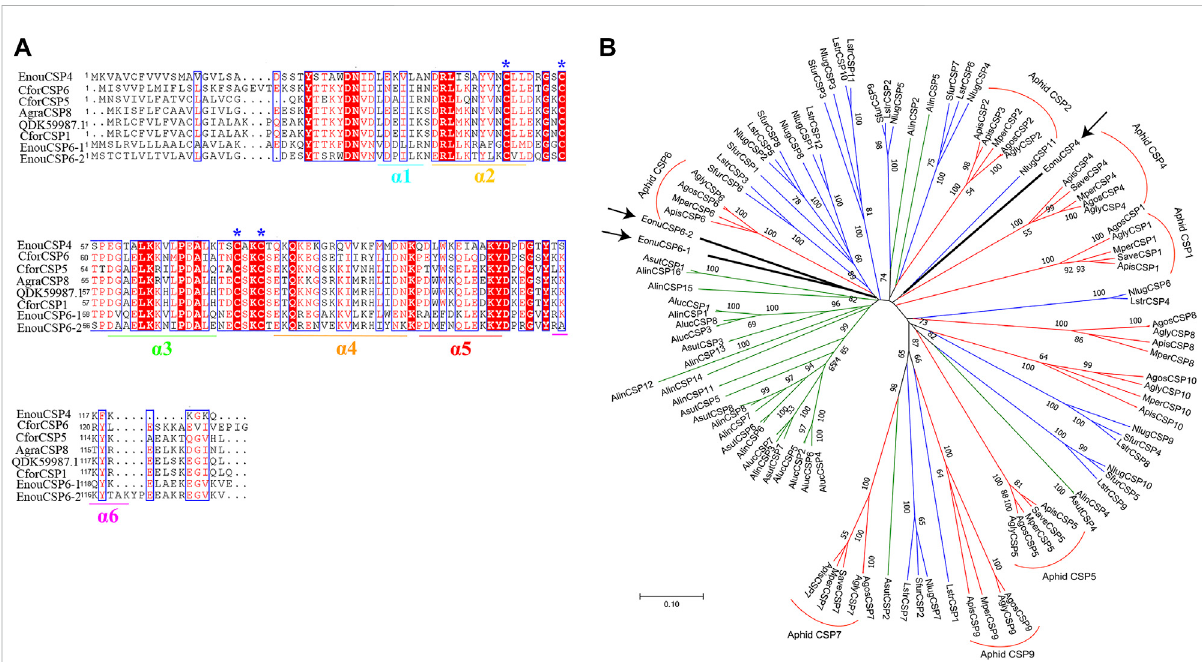
FIGURE 1 Homology analysis and phylogenetic relationship of EonuCSPs with CSPs from other insects. (A) . Secondary structure of E. onukii chemosensory proteins ( EonuCSP4, 6-1 , and 6-2 ). α -helices are displayed as straight. Identical residues are highlighted in white letters with a red background. Residues with similar physicochemical properties are shown in red letters with a blue frame. The conserved cysteines are labeled with asterisk. (B) . Phylogenetic relationshipsoftheCSPs.Species includeshoppers( N.lugens (Nlug) , S.furcifera (Sfur), and L.striatellus (Lstr)],aphids ( A.pisum (Apis) , M.persicae (Mper) ,A.gossypii (Agos) , A.glycines (Agly) , and S.avenae (Save)) , and plantbugs( N. lugens (Alug) , L.striatellus (Lstr) , and S. furcifera (Sfur)). E. onukii CSPs was marked with arrowhead. CSPs are classi fi ed into 8 subfamiliesin Aphid based on previous study (Wang Q. et al., 2019), which were marked in red. The 3 CSPs belonged to aphid CSP4 and aphid CSP6 cluster respectively. Bootstrap values were calculated with 1000 replicates; bootstrap values < 50% were deleted from the